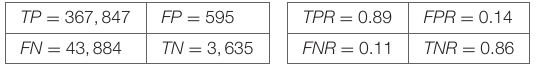
Left: absolute numbers, right: rates. See text for more